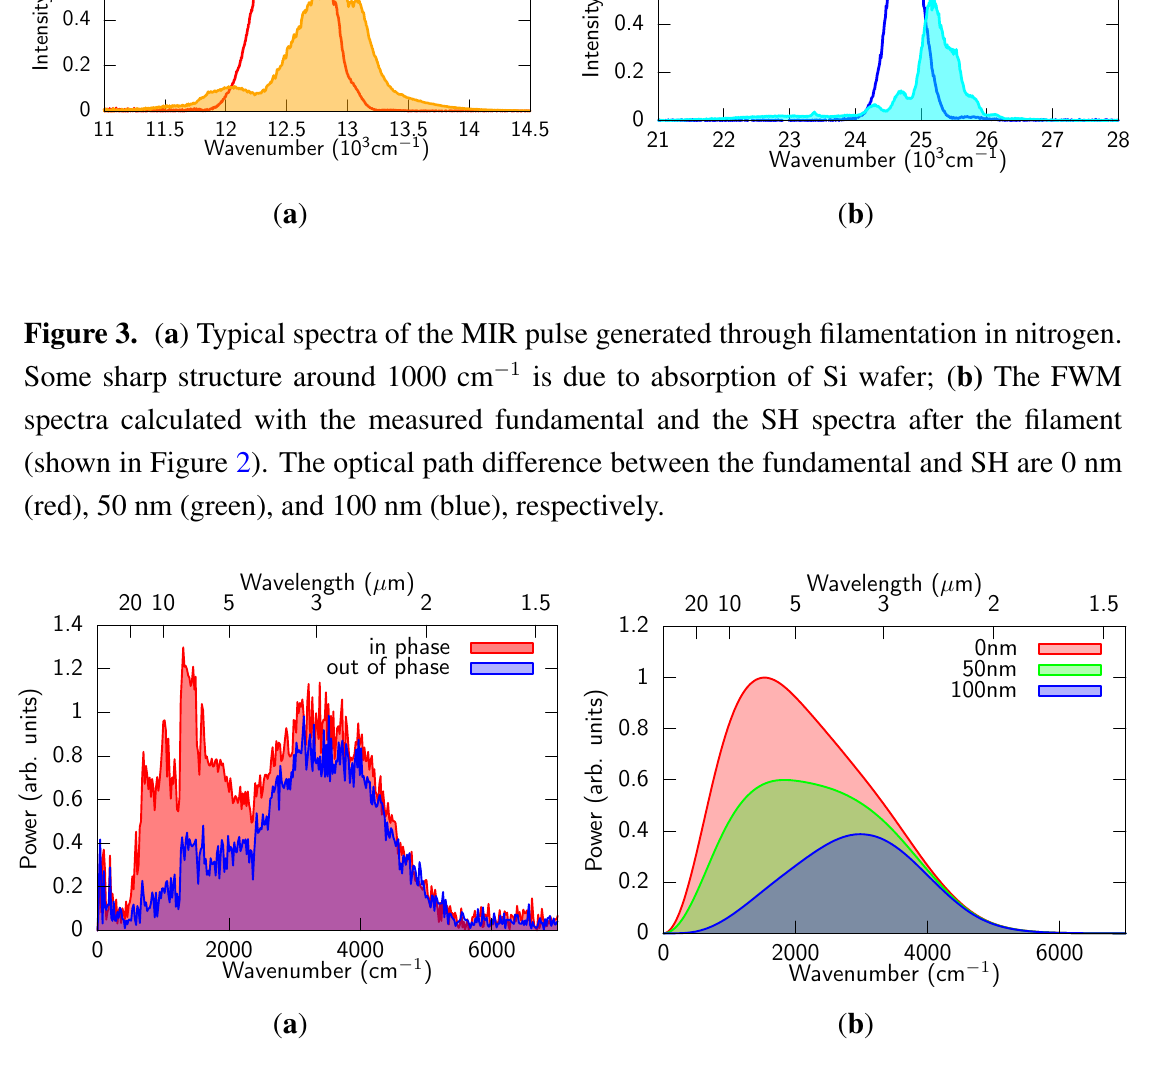
The spectrum of the MIR pulse filtered through ZnSe ( t = 1 mm), Ge ( t = 0 . 5 mm), and two Si ( t = 0 . 5 mm) plates was measured with a home-built Fourier transform spectrometer. The Michelson-type interferometer consisted of a Ge coated KBr beam splitter optimized for 3–20 µ m, silver mirrors, and a feedback-loop piezo electric translation stage (PX400SG, Jena). The beam from the interferometer was focused into a TGS (triglycine sulfate) pyroelectric detector by an